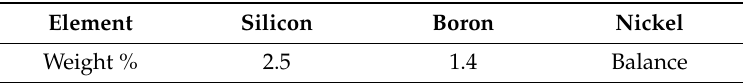
Table 1. The composition of the Delero-22 alloy.